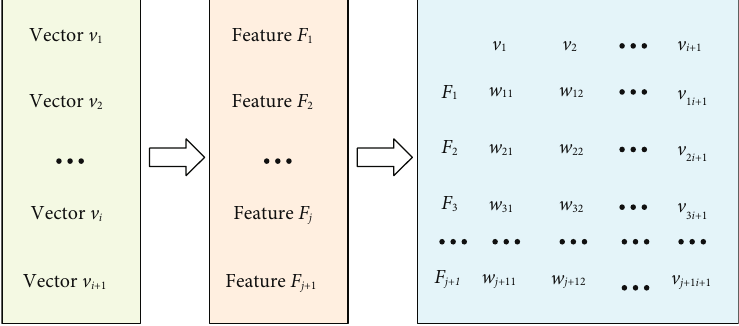
Figure 3: Structure of SVM model.